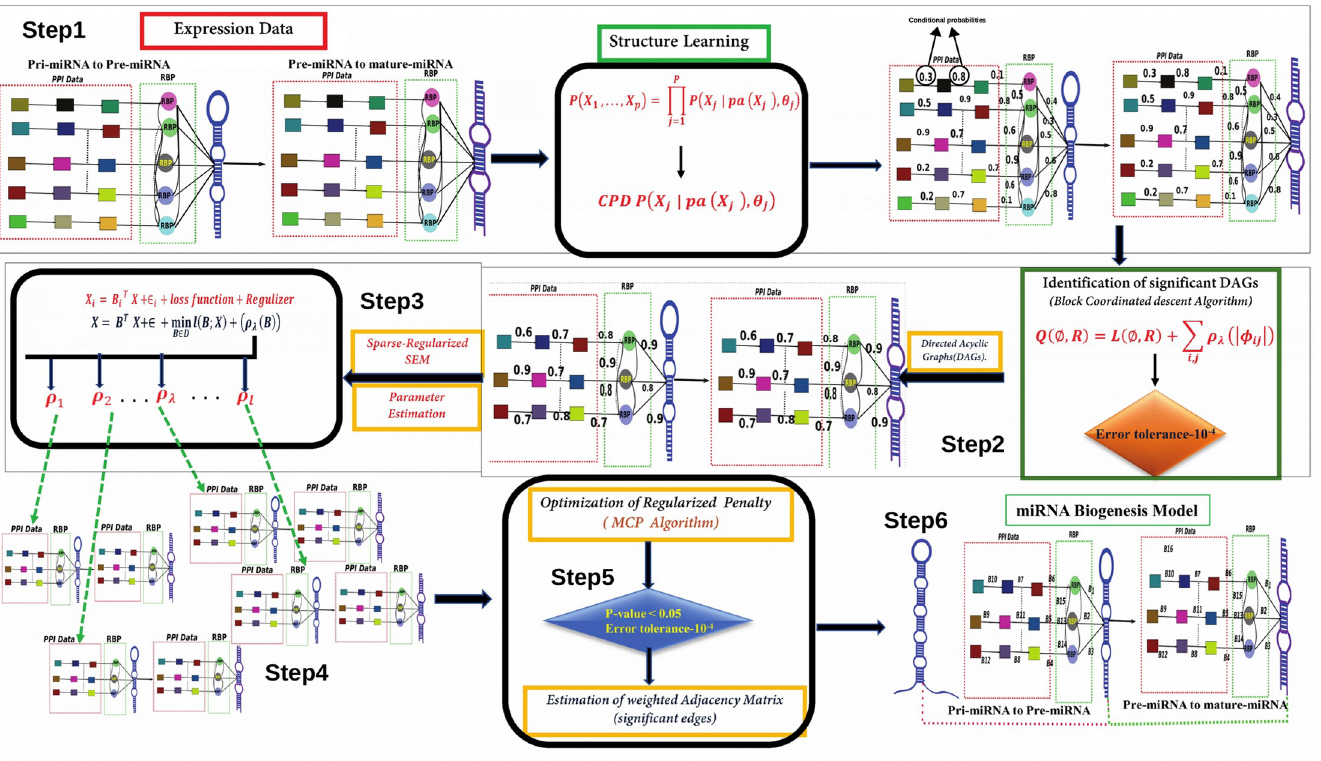
Fig 1. The basic steps taken in Bayesian network reconstruction. Different steps were followed as: 1) Estimation of DAGs between RBP and miRNA, RBP and its PPI partners based on the expression data and prior information. 2) Identification of significant DAGs from total DAGs considering a suitable convergence criteria. 3) The significant DAGs obtained in previous step were directly modeled via a generalized linear model, assuming a multivariate Gaussian distribution. 4) Parameter estimation between RBP and miRNA, RBP and its PPI partners based on the significant DAGs using a sparse regularized penalty. Different set of rho lambda values were taken into consideration and optimum lambda value were selected. 5) Selection of optimum sparse regularized penalty from an array of penalties that fit best to data. 6) Final estimation of parameters using the optimum penalty and selection of parameters considering certain suitable criteria.